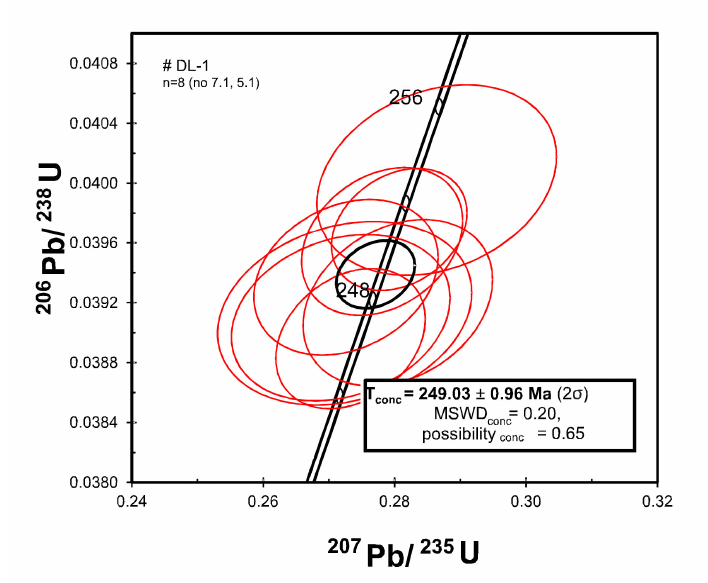
Figure 16. The U–Pb diagram with Concordia for zircon from the gabbro-dolerite Dl-1. Reported ellipses correspond to a 95% level of confidence of analytical